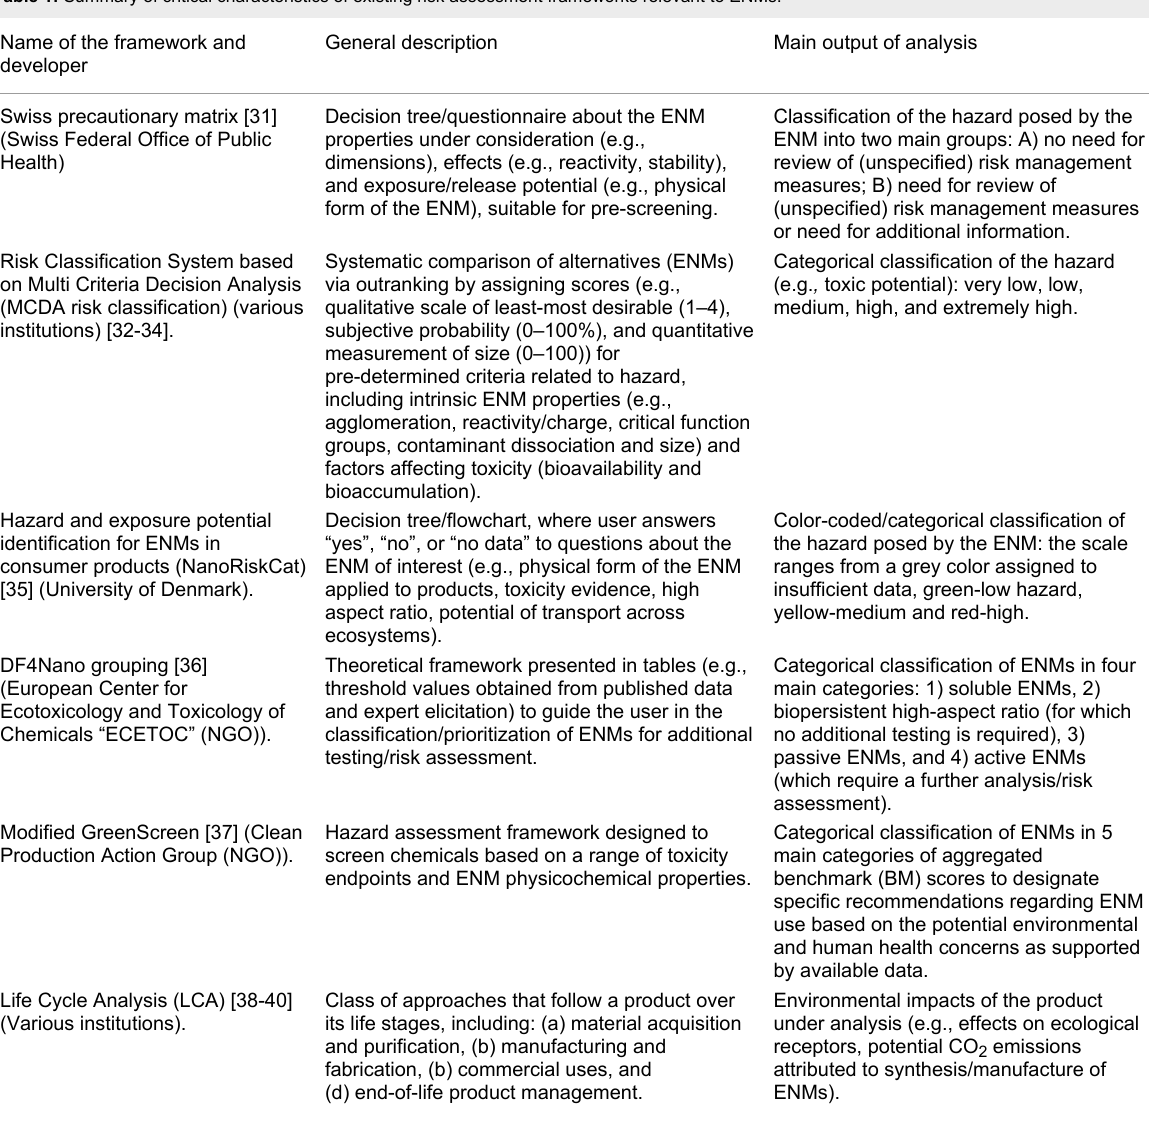
Table 1: Summary of critical characteristics of existing risk assessment frameworks relevant to